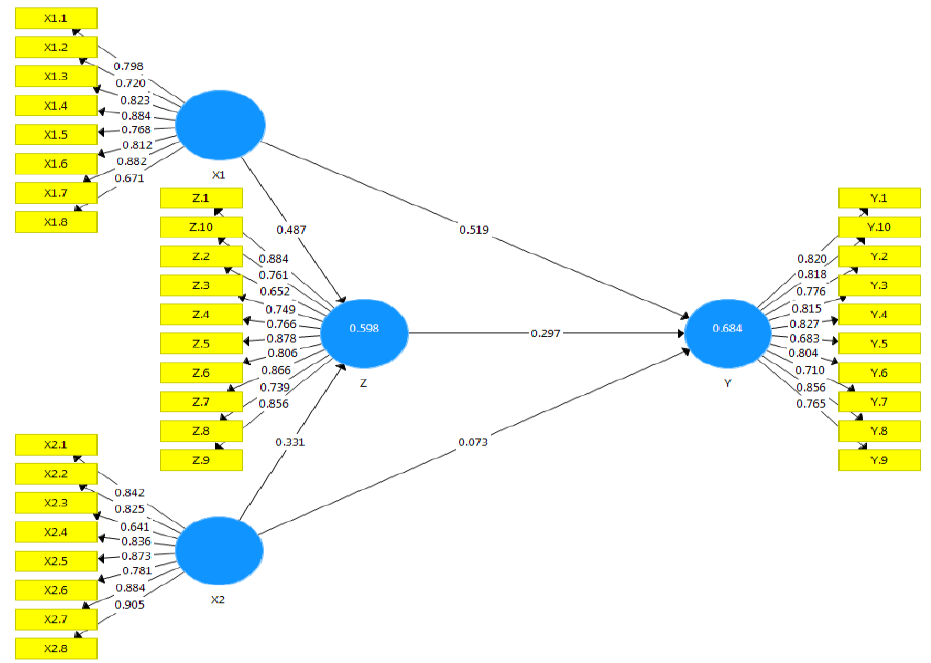
Figure 1: Diagram for Direct Hypothesis Testing; Source : Output of Smart PLS,